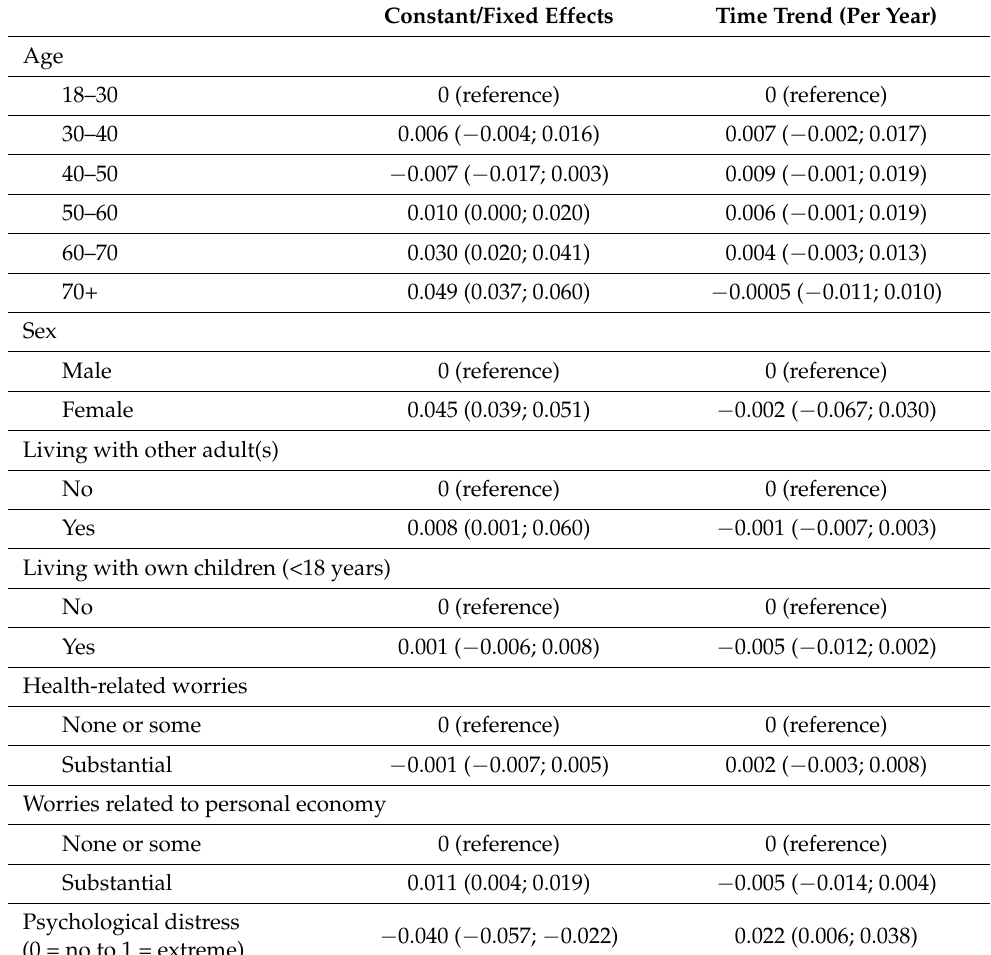
Table 4. Servings per day of fruits and vegetables and associations to psychological distress, worries and baseline characteristics (linear mixed model presenting absolute coefficients with 0 indicat- ing no difference/change, >0 indicating higher intake within group and <0 indicating less intake within